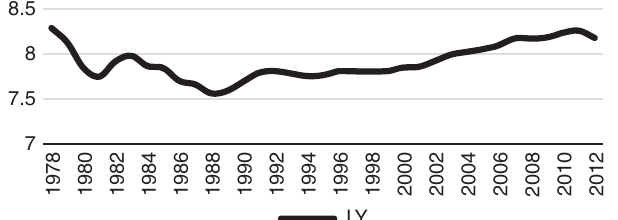
Figure 9. Logarithm of